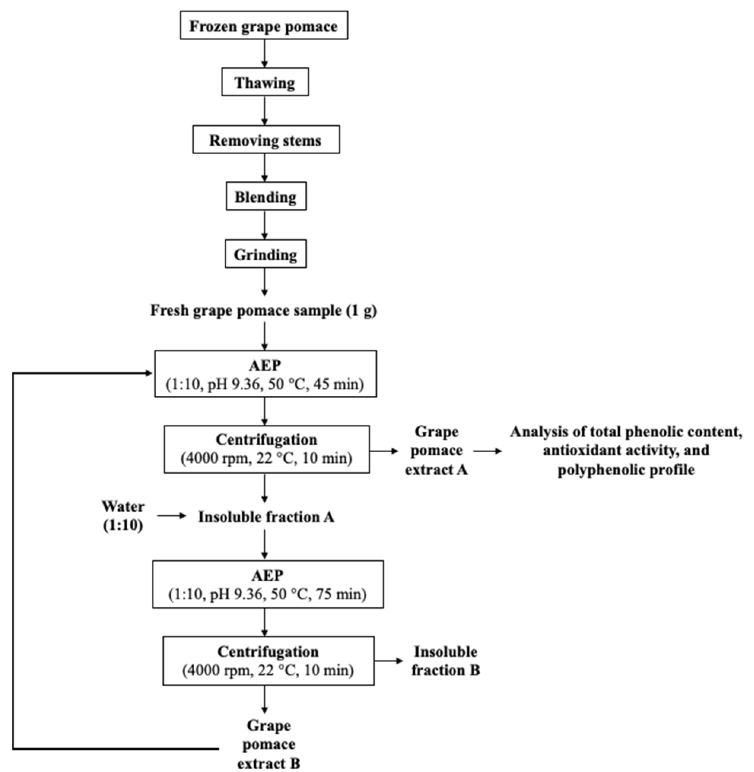
Figure 2. Process flow diagram for the two-stage countercurrent AEP.